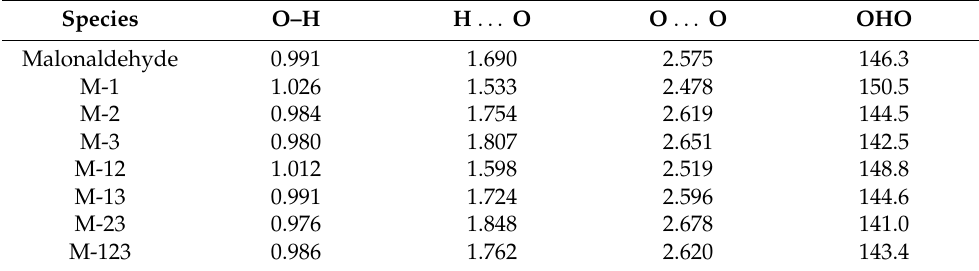
Table 1. Malonaldehyde and its fluoro-derivatives; conformations with intramolecular O–H ··· O hydrogen bonds; geometrical parameters of hydrogen bonds (Å, degrees), M with number designates fluoro-derivative of malonaldehyde with F-substituent/s at carbon atom/s, 1—at carbon connected with hydroxyl group, 2—at “middle carbon”, 3—at carbonyl group carbon, see Scheme 1. Species O–H H . . . O O . . . O OHO Species Malonaldehyde